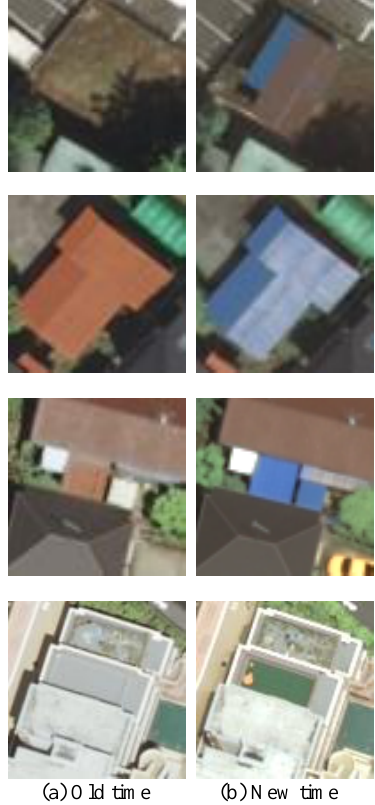
Fig.9. Changed buildings not extracted by texture extraction